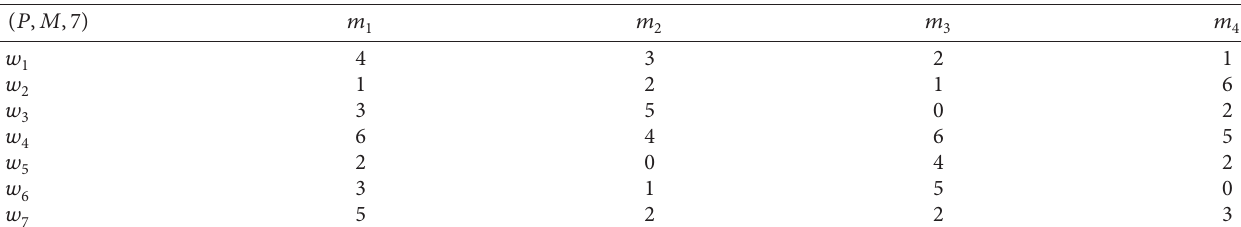
Table 19: Identified 7-soft set.